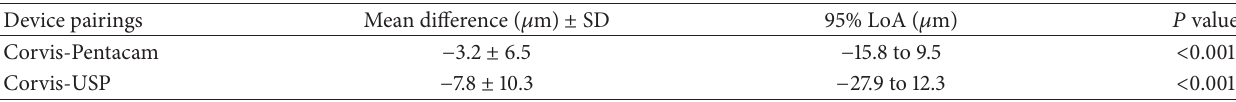
Table3:ComparisonofthecentralcornealthicknessreadingsobtainedusingthecornealdynamicScheimpfluganalyzerCorvisST,Pentacam rotating Scheimpflug system, and ultrasound pachymetry. Device pairings Mean difference ( 𝜇 m) ± SD 95% LoA ( 𝜇 m) 𝑃 value Corvis-Pentacam − 3.2 ±